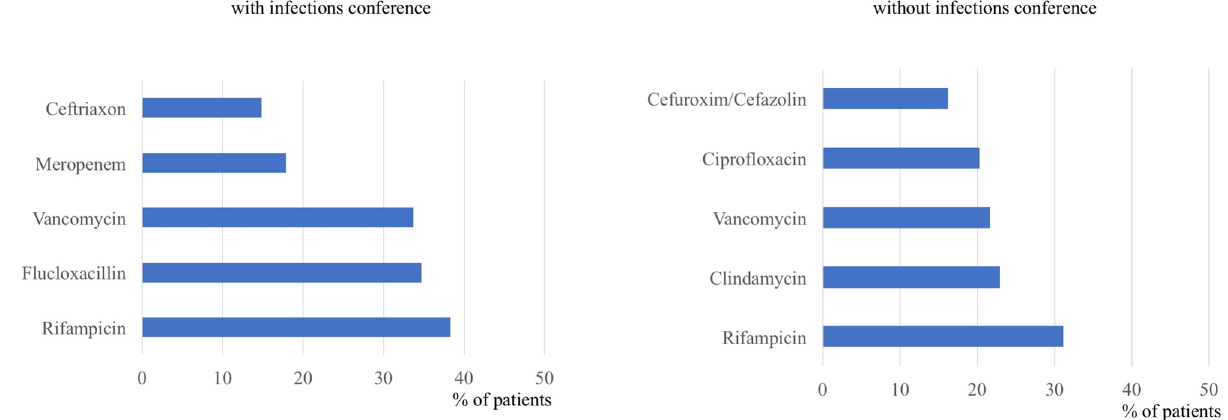
Figure 2. Relative distribution of top five intravenous antibiotics used in both groups. Number of patients included: 74 (without infections conference), 196 (with infections conference).